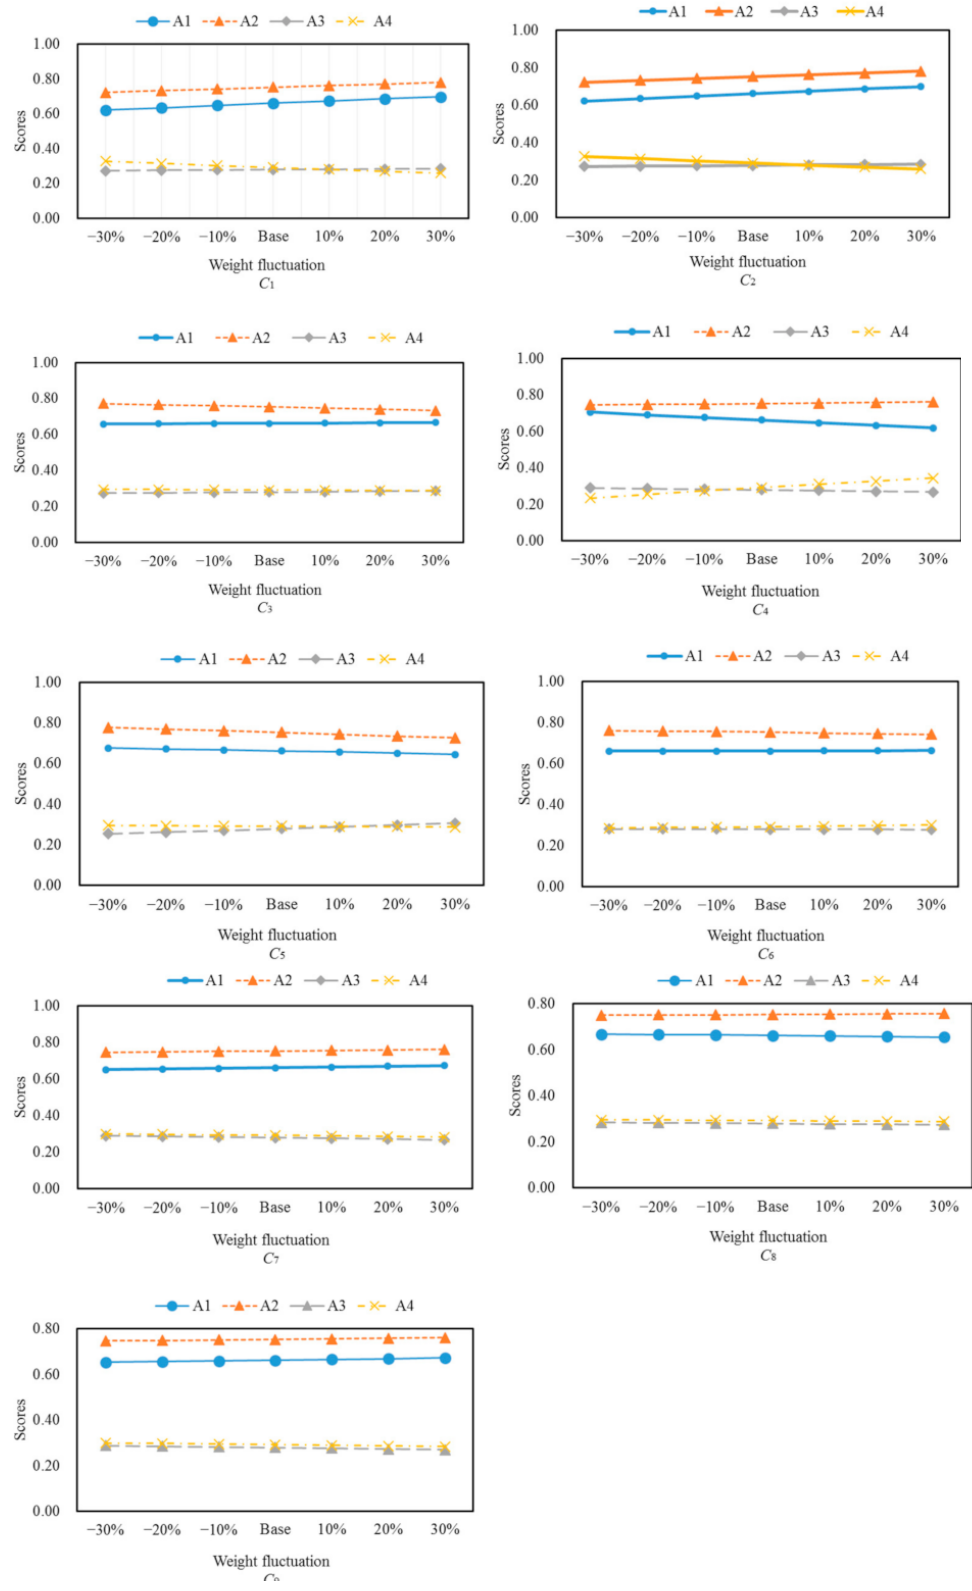
Figure 6. Sensitivity analysis